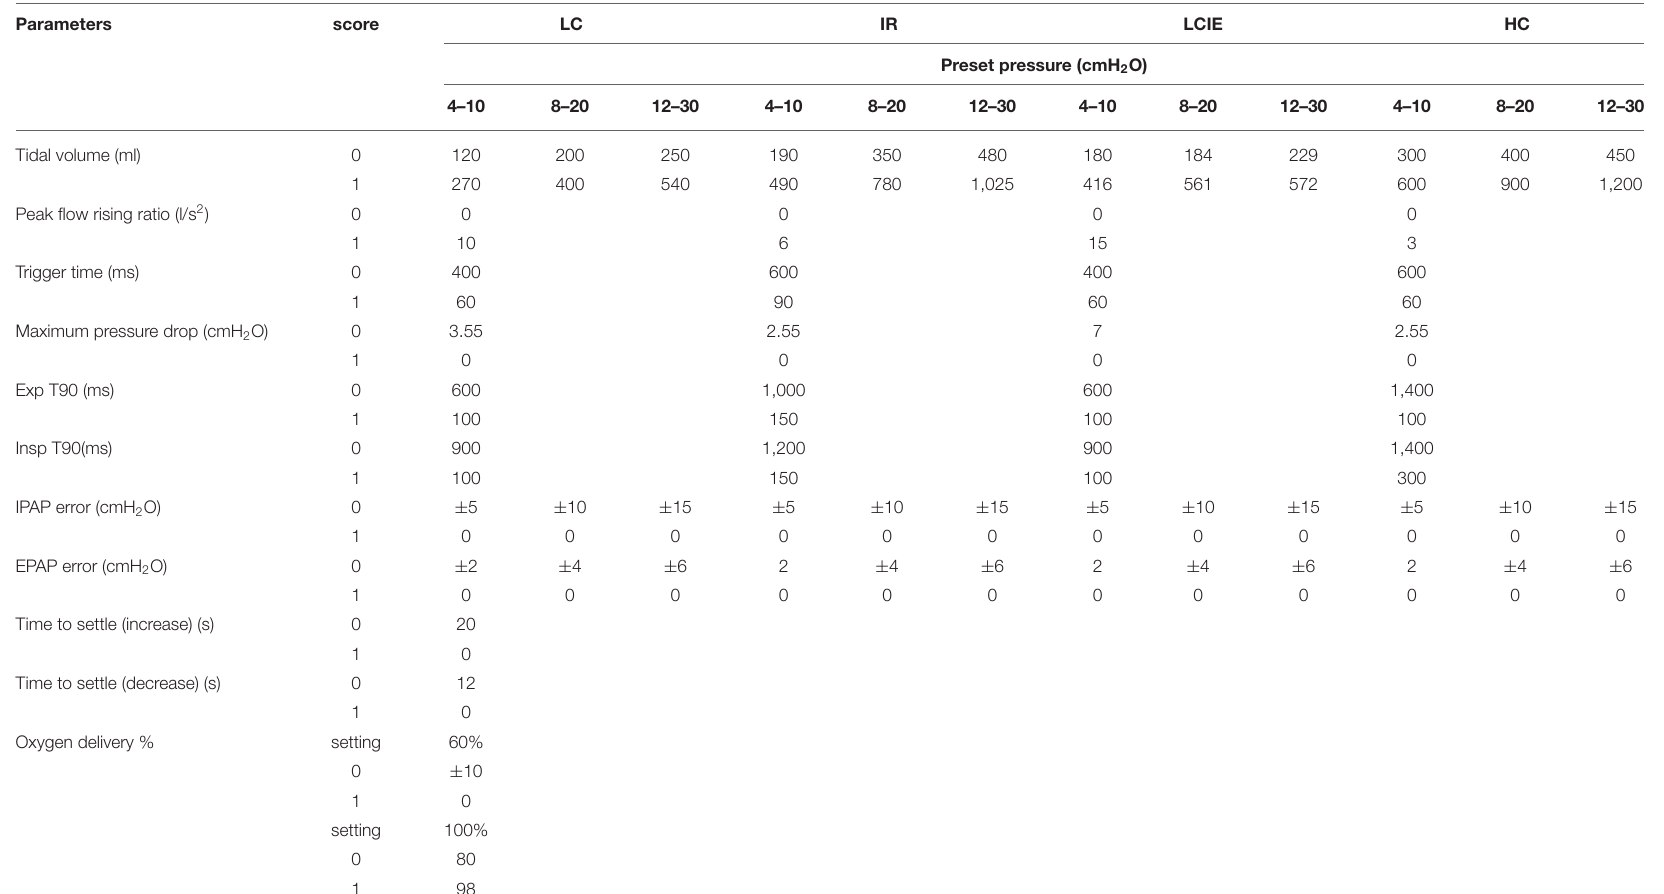
TABLE 2 | Ranges of the targeted